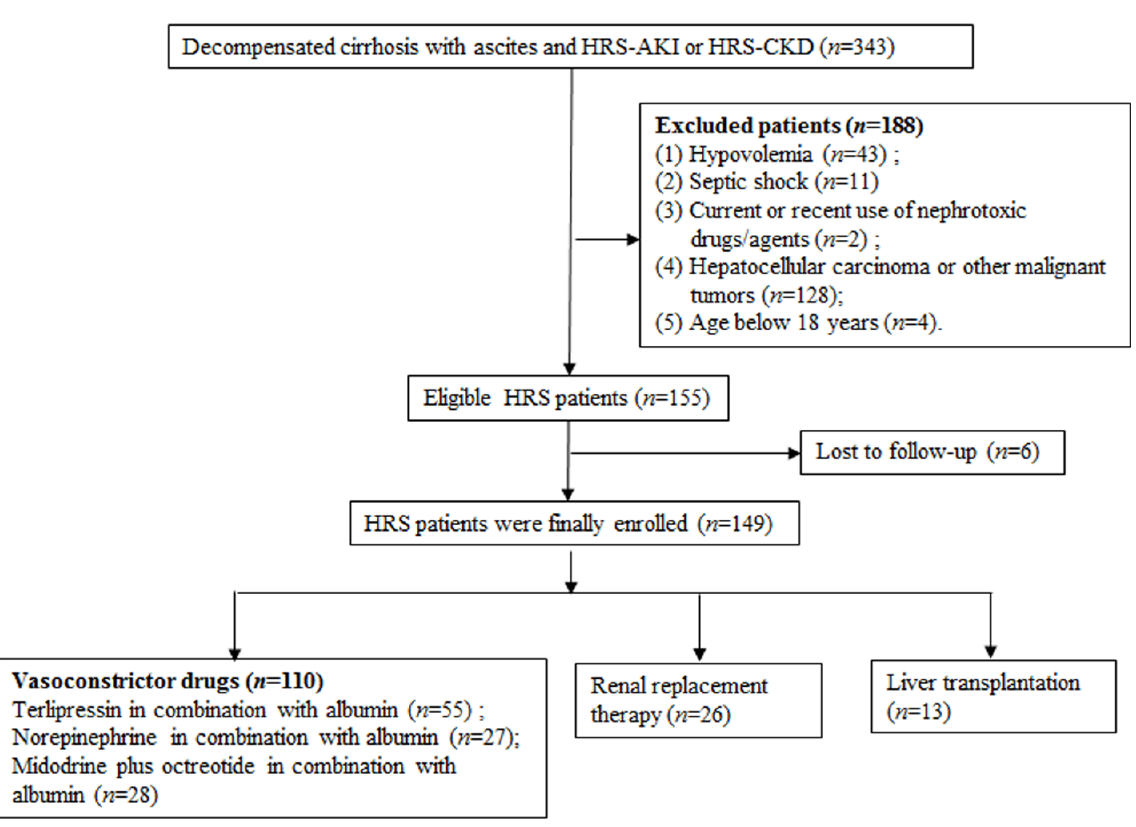
Figure 1. Flowchart of patient enrollment. Abbreviations: HRS, hepatorenal syndrome; AKI, acute kidney injury; CKD, chronic kidney disease.